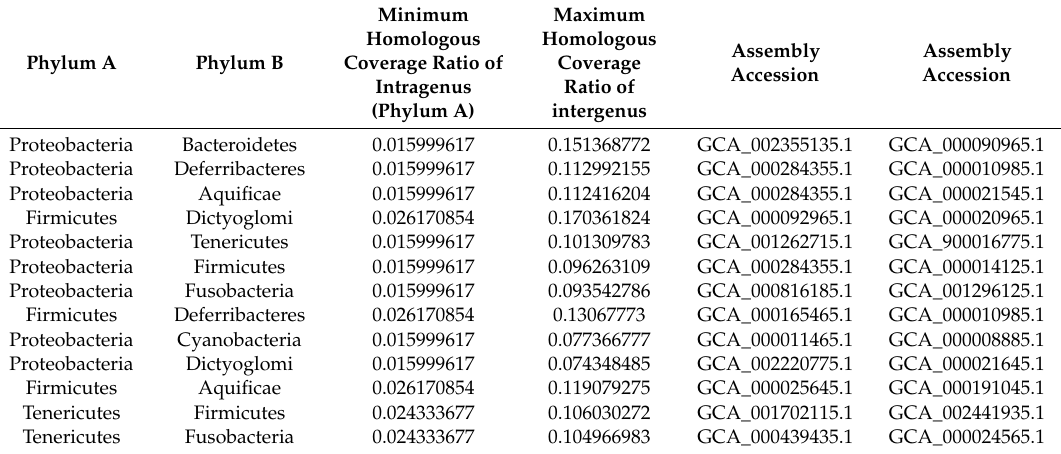
Figure 2. Multidimensional scaling ordination plot based on the homologous distances among microorganisms, including 2227 strains. Different colors represent different phyla. Table 2. Top 13 pairs of assembly accessions with maximum interphylum homologous coverage ratio.